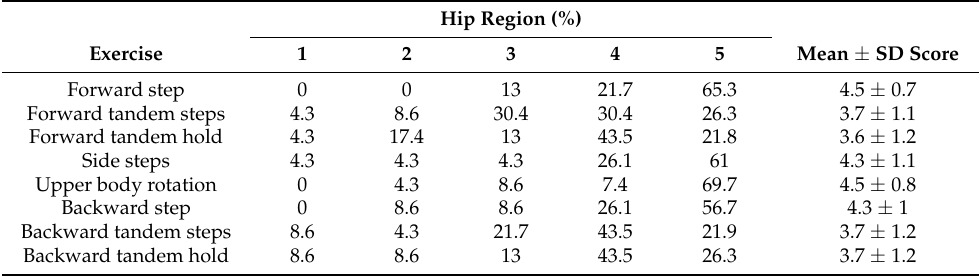
Table 7. Difficulty scores of the exercises performed at the hip region.